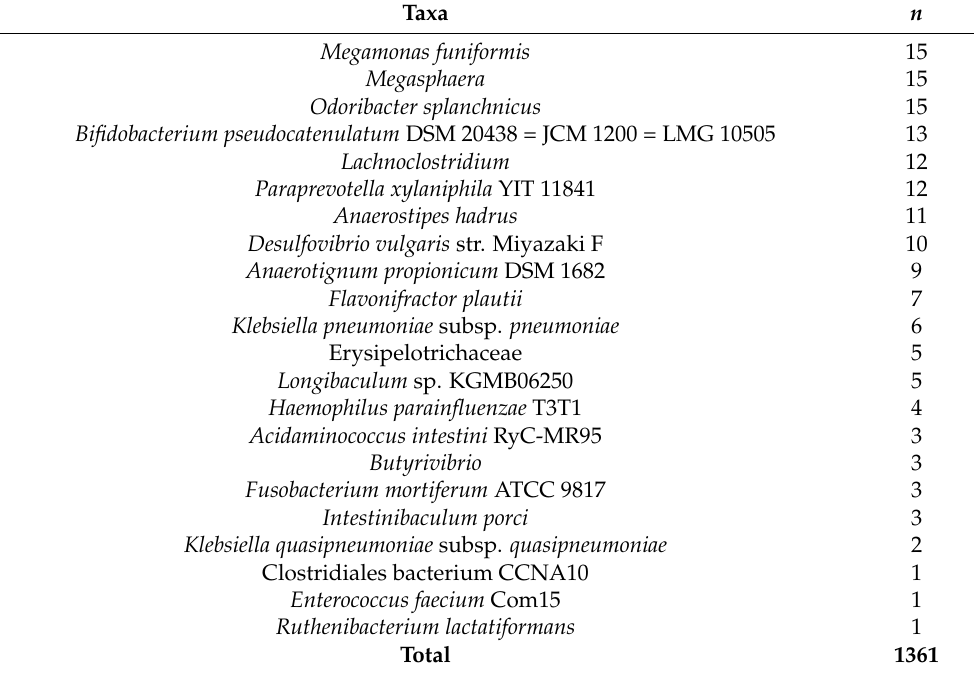
Table 2. Cont. MAGs Found in the Microbiota of Healthy Individuals That Were also Found in the Microbiota of Patients with Crohn’s Disease Taxa n Megamonas funiformis 15